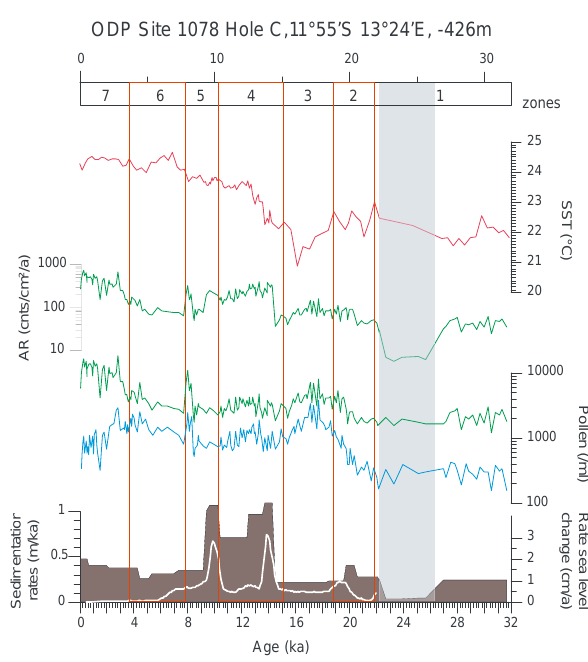
Fig. 4. From top to bottom. Pollen zones. Alkenone based sea surface temperatures (red line, upper right axis). Accumulation rates of total pollen per cm 2 per a (green line, upper left axis). Total pollen concentration (green line) and Podocarpus pollen concentration (blue line) per ml sediment (middle right axis). Sedimentation rates in m per ka (shaded, lower left axis) and rates of sea-level change (line, lower right axis) after Fleming et al. (1998).